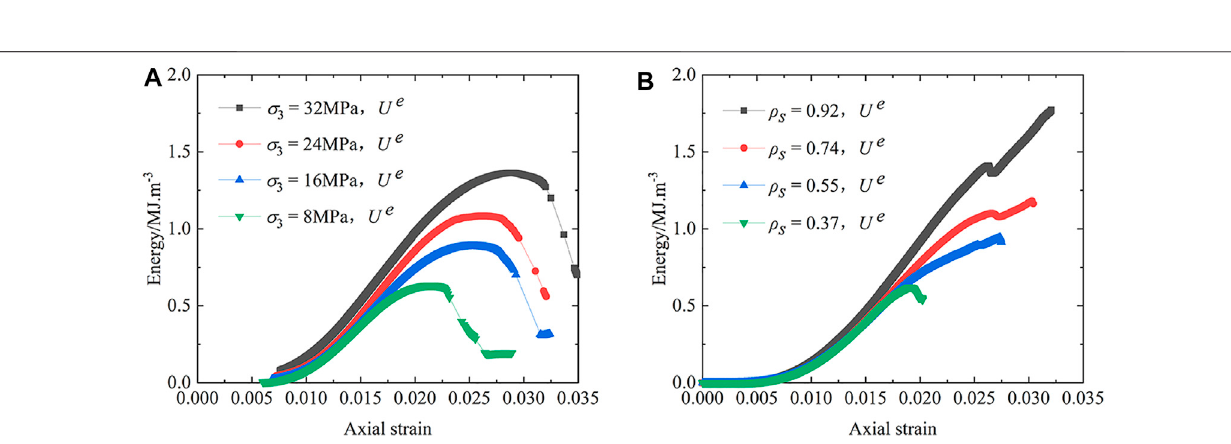
FIGURE 8 | Energy evolution curve of the specimen under different con fi ning stiffness. (A) ρ s (cid:1) 0 . 37; (B) ρ s (cid:1) 0 . 55; (C) ρ s (cid:1) 0 . 74; (D) ρ s (cid:1) 0 . 92.